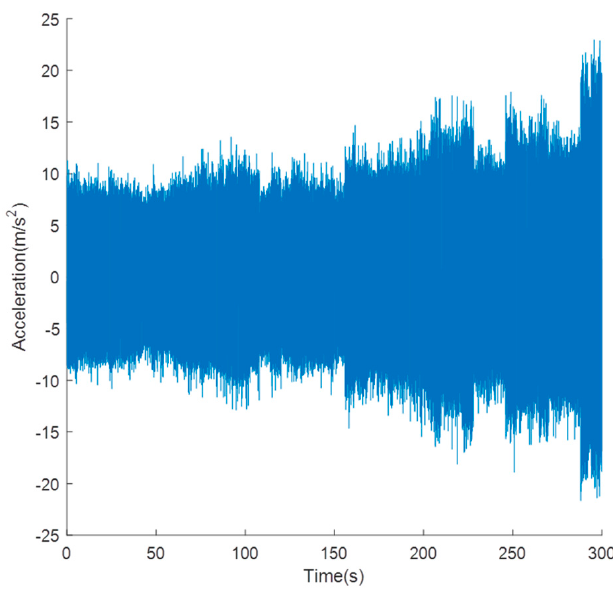
Figure 4. Raw vibration signals bearing run to failure, 6 s per day, 50 days in total [30].